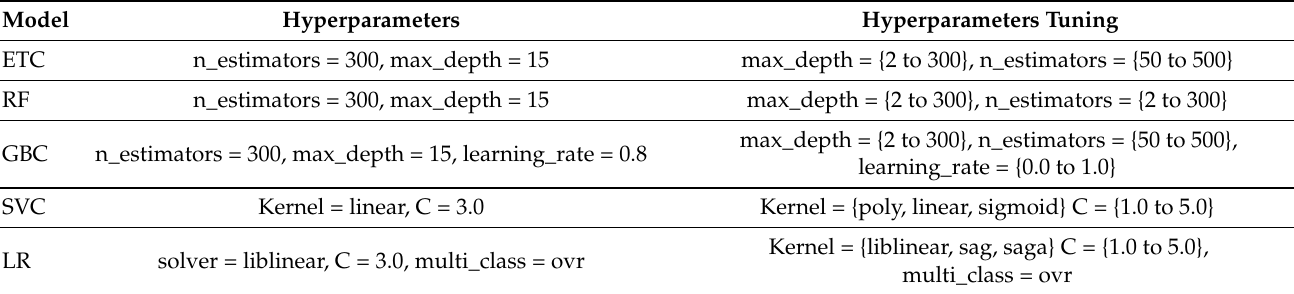
Table 5. Machine learning models’ hyperparameters